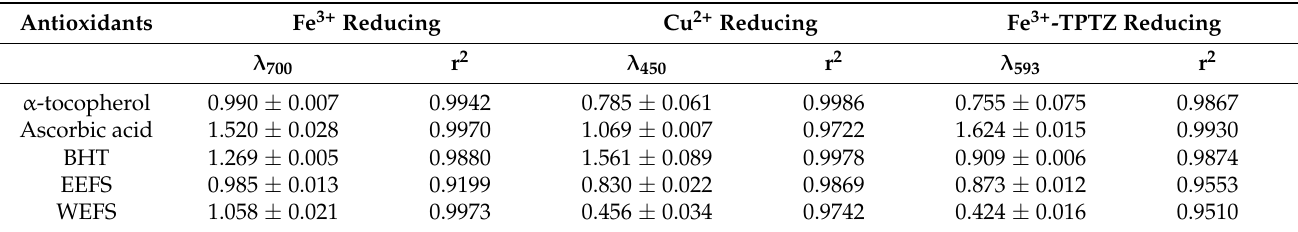
Table 1. The reducing power of the EEFS and WEFS and standards antioxidants by Fe 3+ reducing (120 µ g/mL), Cu 2+ reducing (30 µ g/mL), and Fe 3+ -TPTZ reducing (150 µ g/mL) methods ((EEFS: evaporated ethanolic extract of aerial parts kınkor ( Ferulago stellata ); WEFS: lyophilized water extract of aerial parts of kınkor ( Ferulago stellata ); TPTZ: 2,4,6-tris(2- pyridyl)-s-triazine).